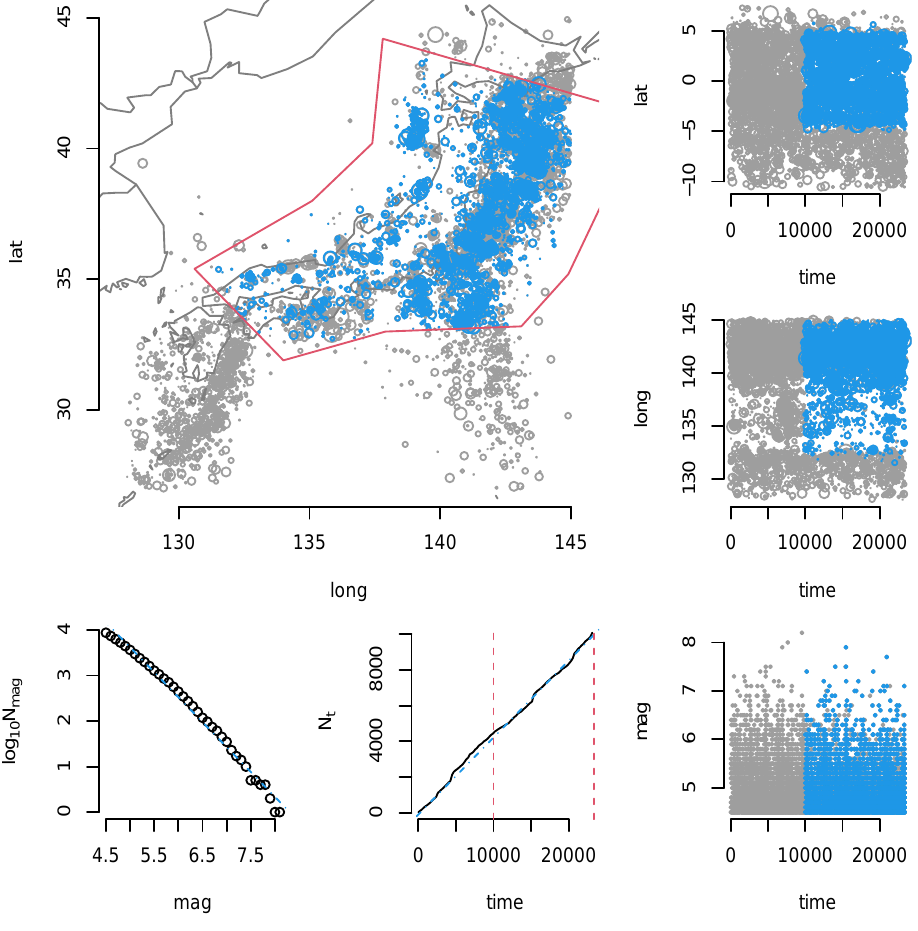
Figure 7. The plots of the earthquake catalog of Japan. Table 9. The CML estimates of the fitted INAR(1) models and corresponding GOF